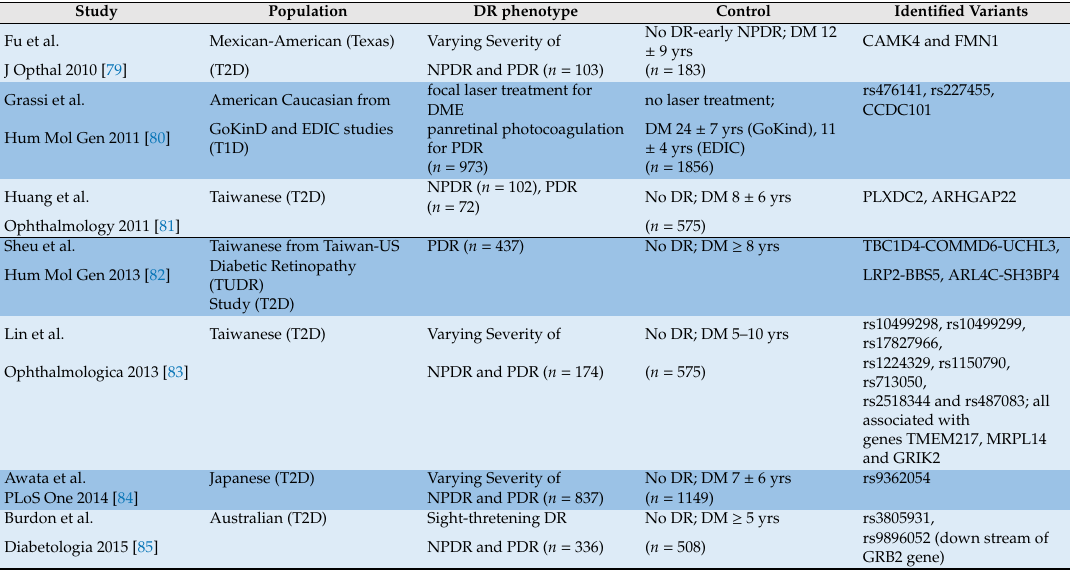
Table 2. Genome-Wide Association Studies of Diabetic Retinopathy-associated Risk Genes in Various